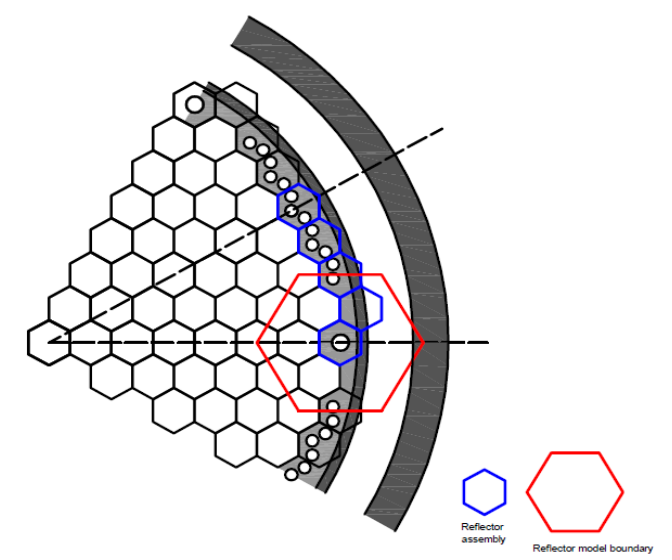
Figure 3. Reflector